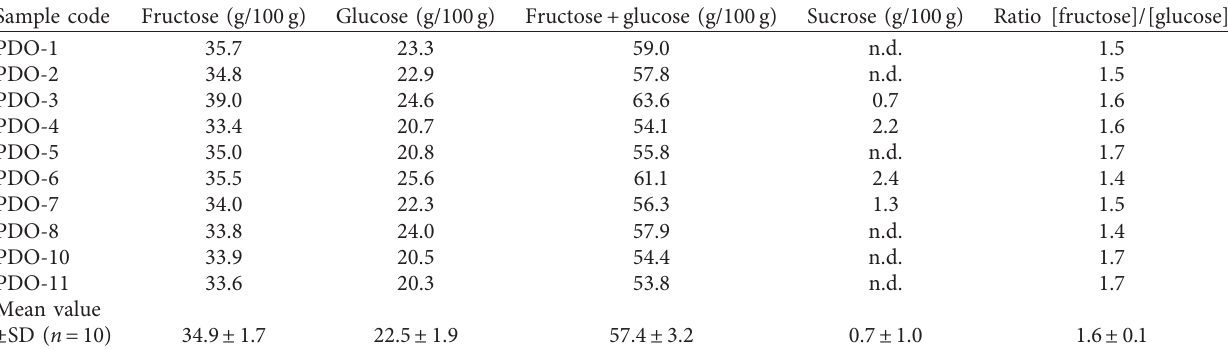
Table 3: Results for the determination of fructose, glucose, and sucrose in PDO “Pefkothymaromelo Kritis” (blend thyme-pine honey) ( n �